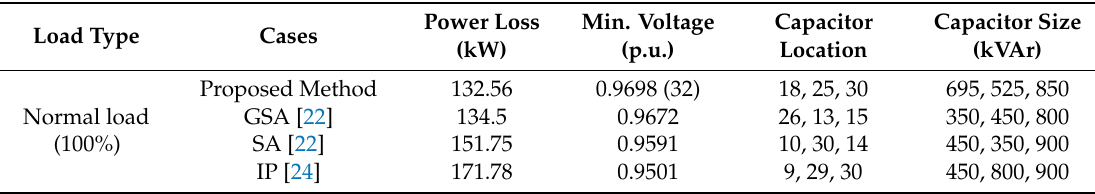
Table 2. Outcomes obtained by the proposed methodology with GSA, SA, and IP [25] and for normal load.